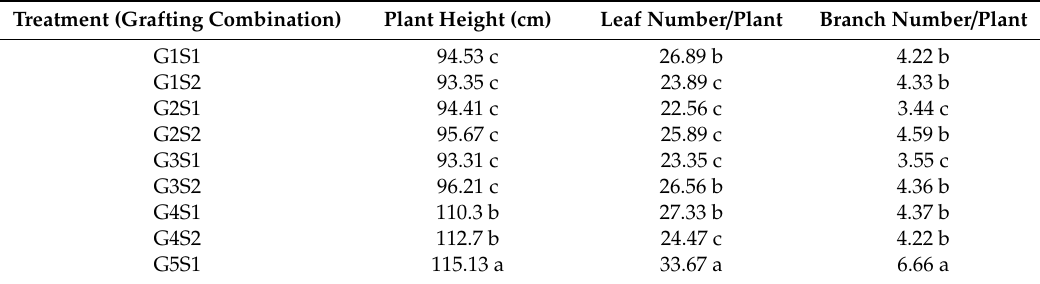
Table 3. E ff ect of di ff erent graft combinations on growth characteristics of pomato plants. Table 3. Effect of different graft combinations on growth characteristics of pomato plants. Treatment (Grafting Treatment (Grafting Combination)